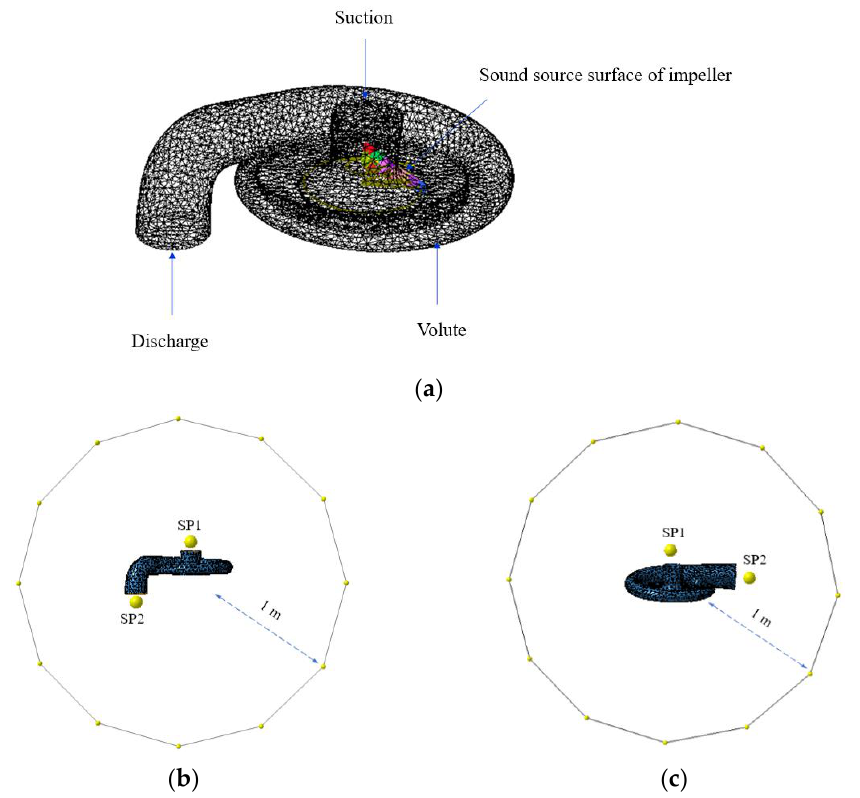
Figure 12. Aeroacoustic prediction model. ( a ) Acoustic model of the centrifugal air compressor. ( b ) Field point setting of the first stage volute. ( c ) Field point setting of the second stage